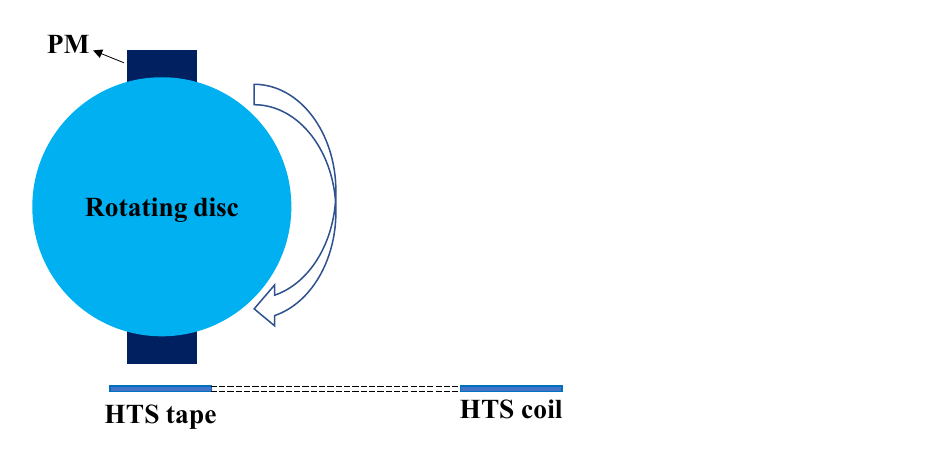
Figure 4. Cross section view of a rotary HTS flux pump equipped with two PMs.